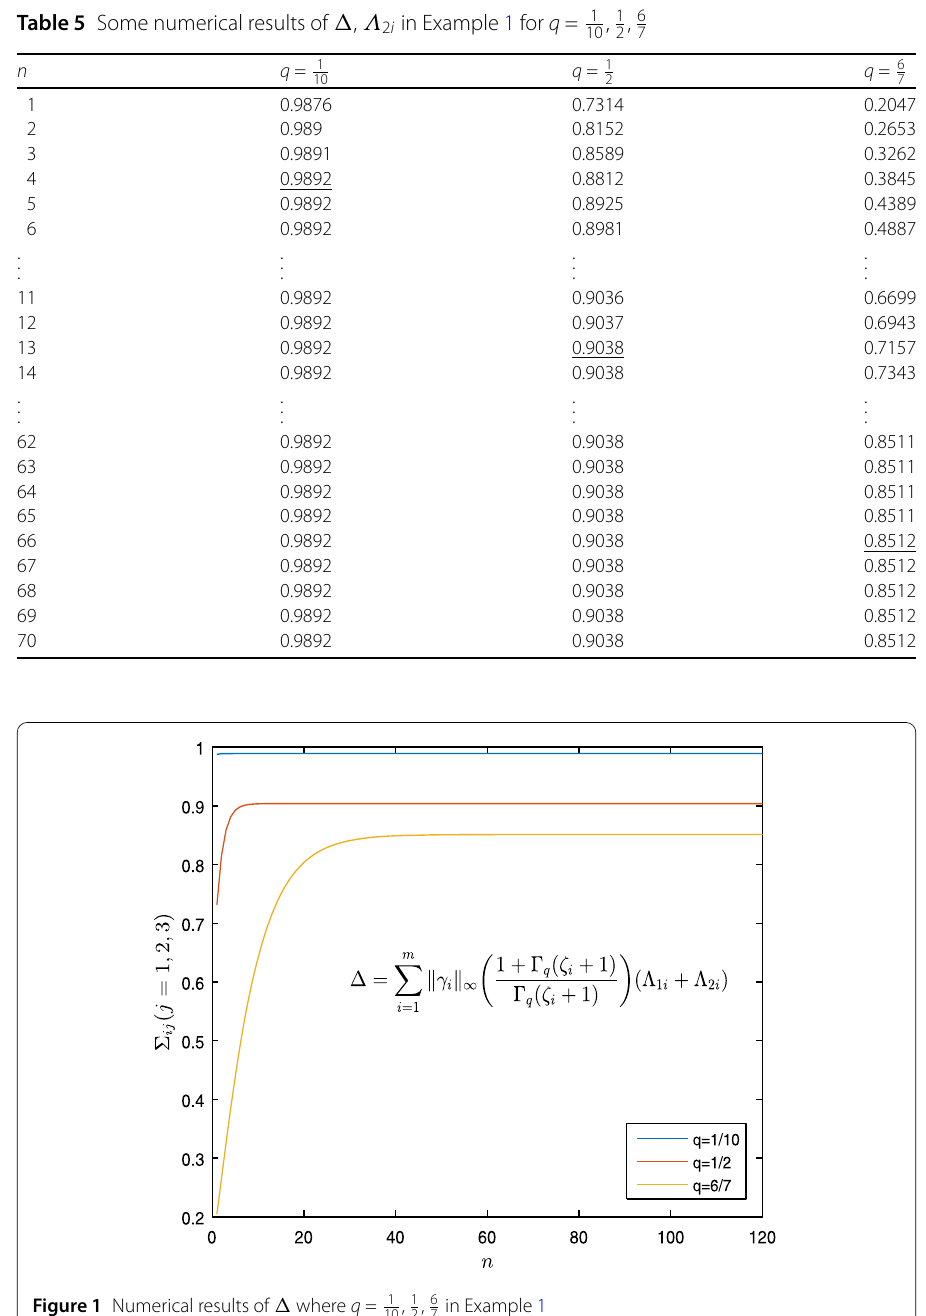
Figure 1 Numerical results of (cid:17) where q = 1